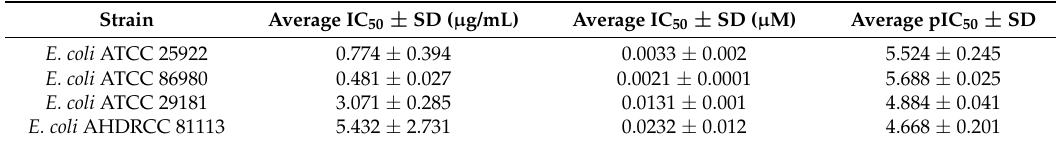
Figure 1. The chemical structure of the thiosemicarbazone NSC319726 lead. Table 2. Average IC 50 ± standard deviation (SD) ( µ g/mL and µ M) and average pIC 50 ± SD for NSC319726. Averages IC 50 and SD were calculated on the basis of N1, N2, and N3 data of the secondary screen for all strains and tested compounds.